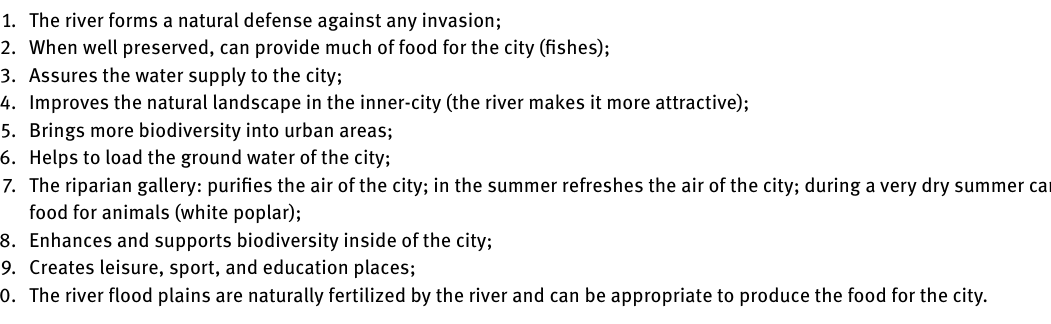
Figure 1: Illustration and description of the services provided by the river to urban